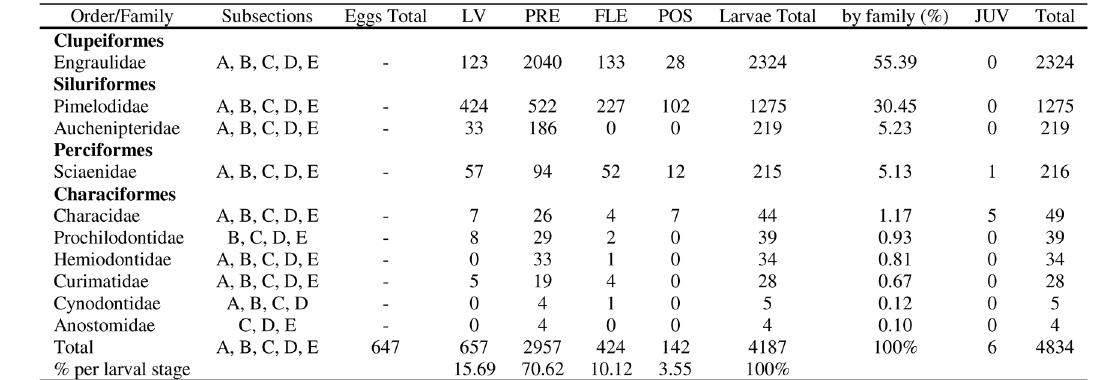
Table 2. Number of fish eggs, larvae and juveniles caught at the Anavilhanas Ecological Station. Larvae % by family and